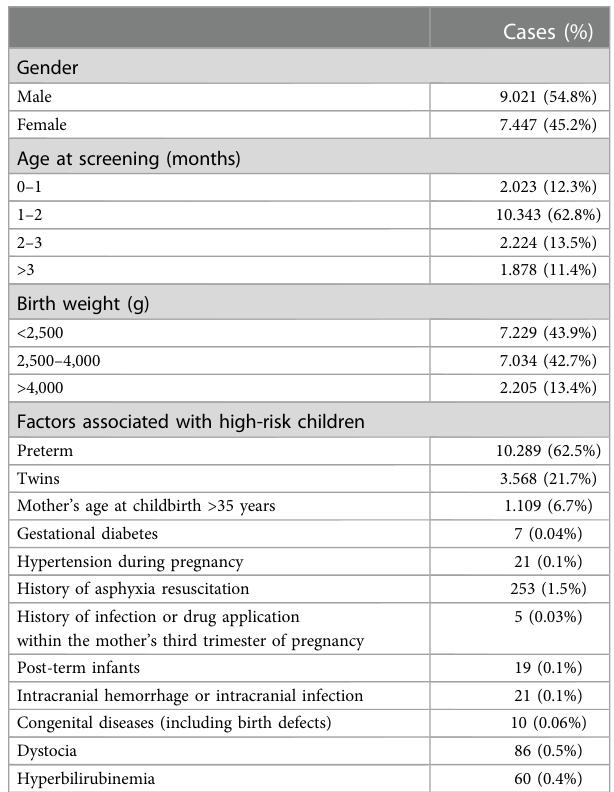
TABLE 2 General information on high-risk children undergoing ultrasound